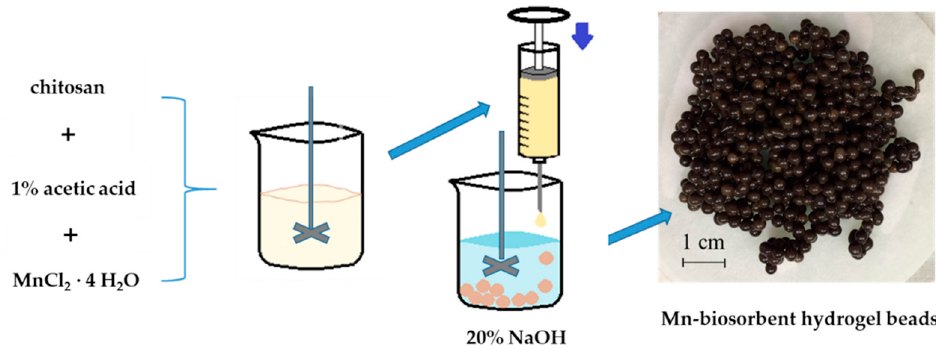
Figure 1. Scheme of synthesis process of the Mn-biosorbent hydrogel beads [28].